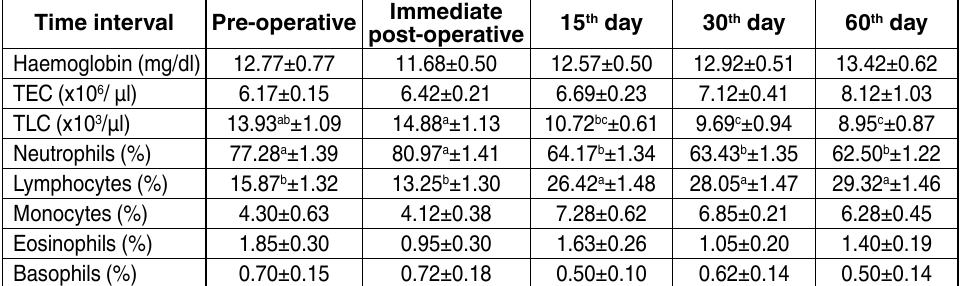
table 7. Mean ± S.E. values of different haematological parameters of all the cases at different time intervals of